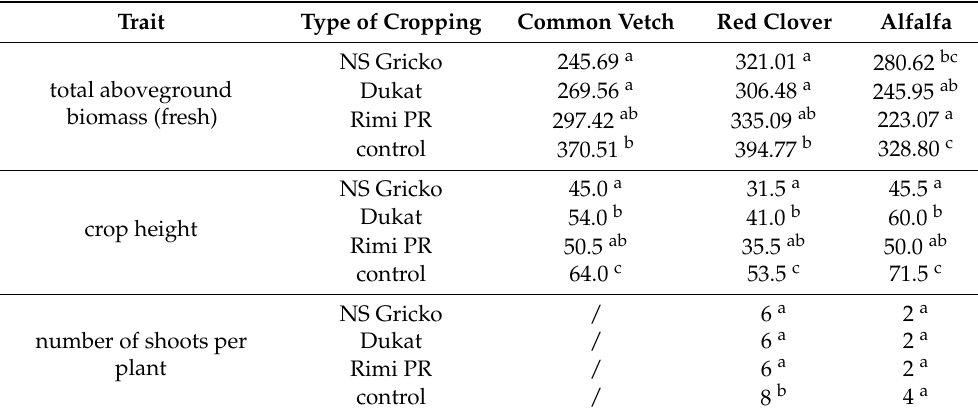
Table 7. Least-square means difference for legume traits analyzed by selected models in sunflower legume intercropping.